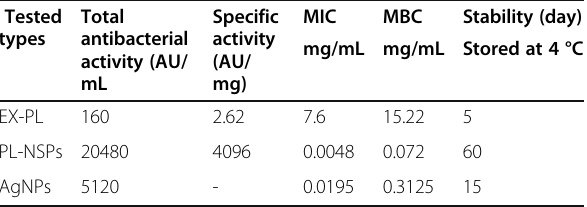
Specific activity is the activity units divided by the protein concentration